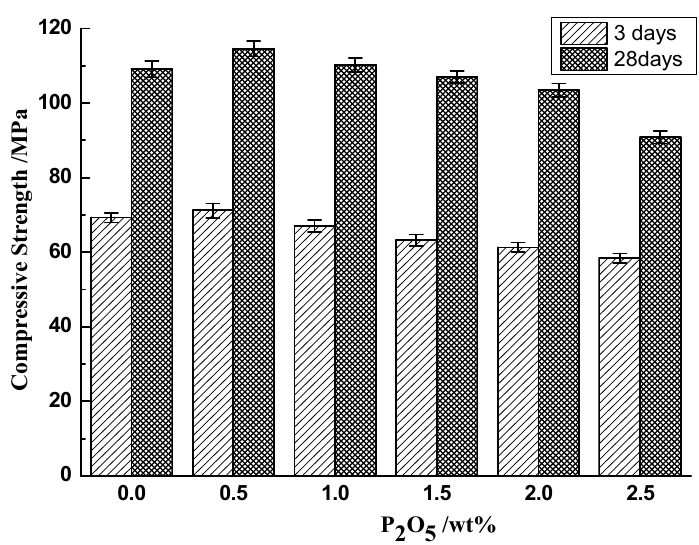
Figure 12. Compressive strengths of the cement pastes prepared with phosphorous-bearing clinkers and hydrated for 3 and 28 days.